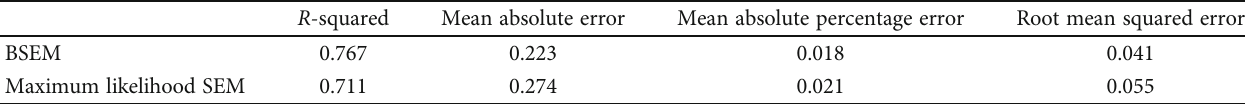
Table 8: Performance of the Bayesian and maximum likelihood